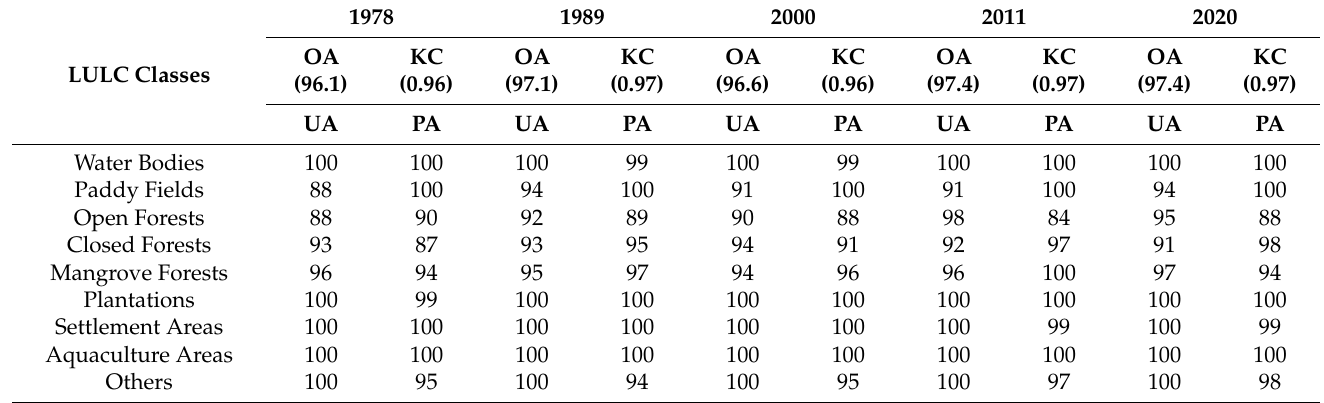
Table 3. User’s accuracies (UA, %), producer’s accuracies (PA, %), overall accuracies (OA, %), and Kappa coefficients (KC) of classified datasets for LULC classes: Water Bodies, Paddy Fields, Open Forests, Closed Forests, Mangrove Forests, Plantations, Settlement Areas, Aquaculture Areas, and Others of Kyunsu township, Southern Myanmar, in 1978, 1989, 2000, 2011, and